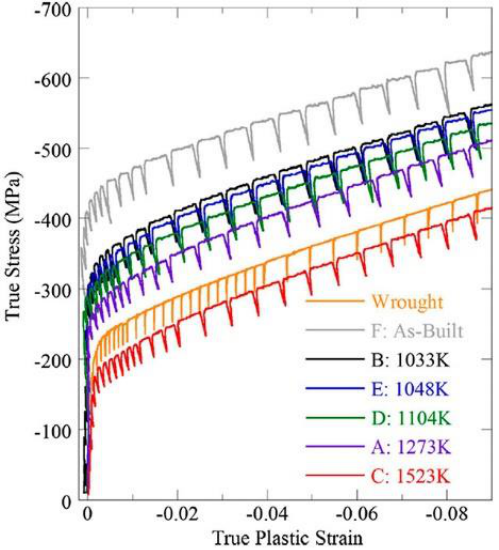
Figure 7. Macroscopic stress/strain curves for AM-fabricated 304L steel in dependence on post-built heat treatments. The stress drops are due to relaxation during the neutron diffraction data collection periods which were made in the authors’ experiments. Reprinted with permission from [50], Copyright 2019 Springer Nature.